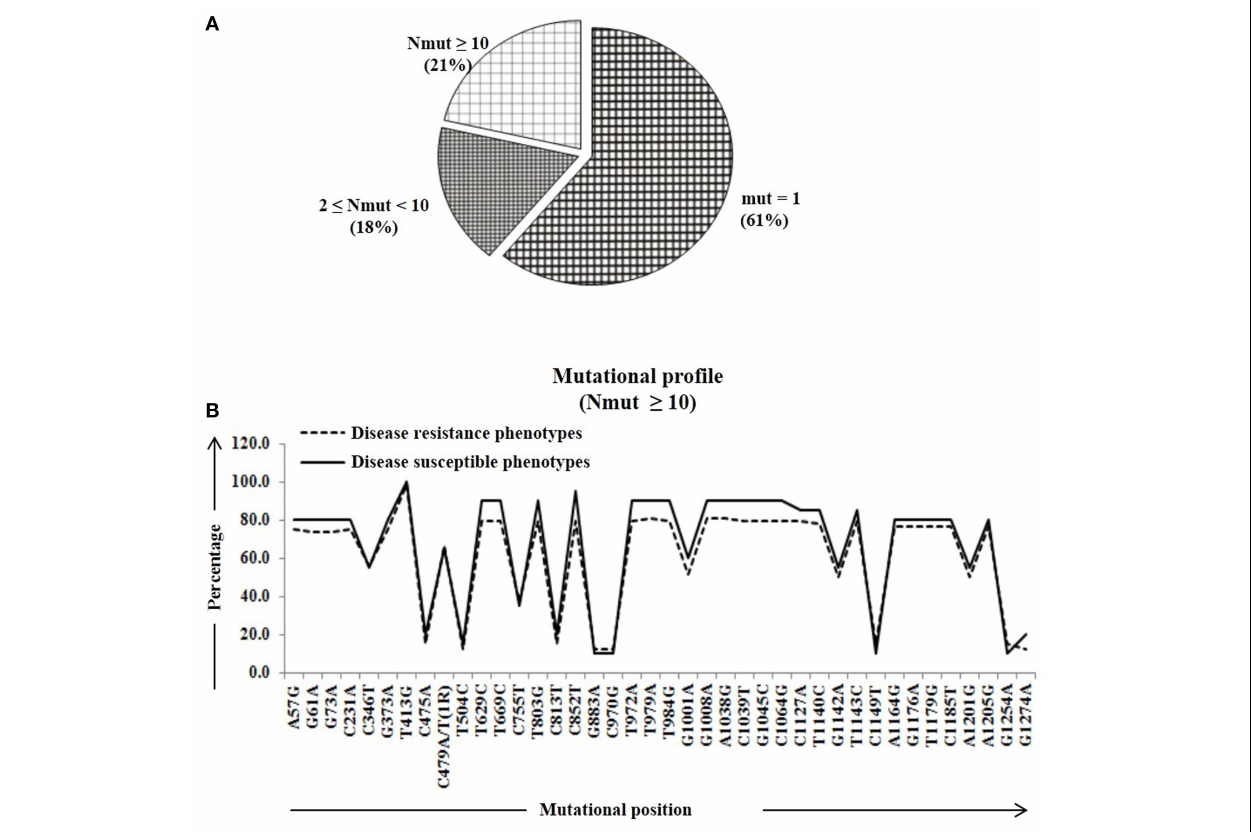
FIGURE 2 | The number of amino acid substitutions in the predicted 64 Pi54 protein. (A) Distribution of amino acid substitutions across 64 predicted proteins. (B) Substitutional profile of amino acids of disease resistant and susceptible phenotype.